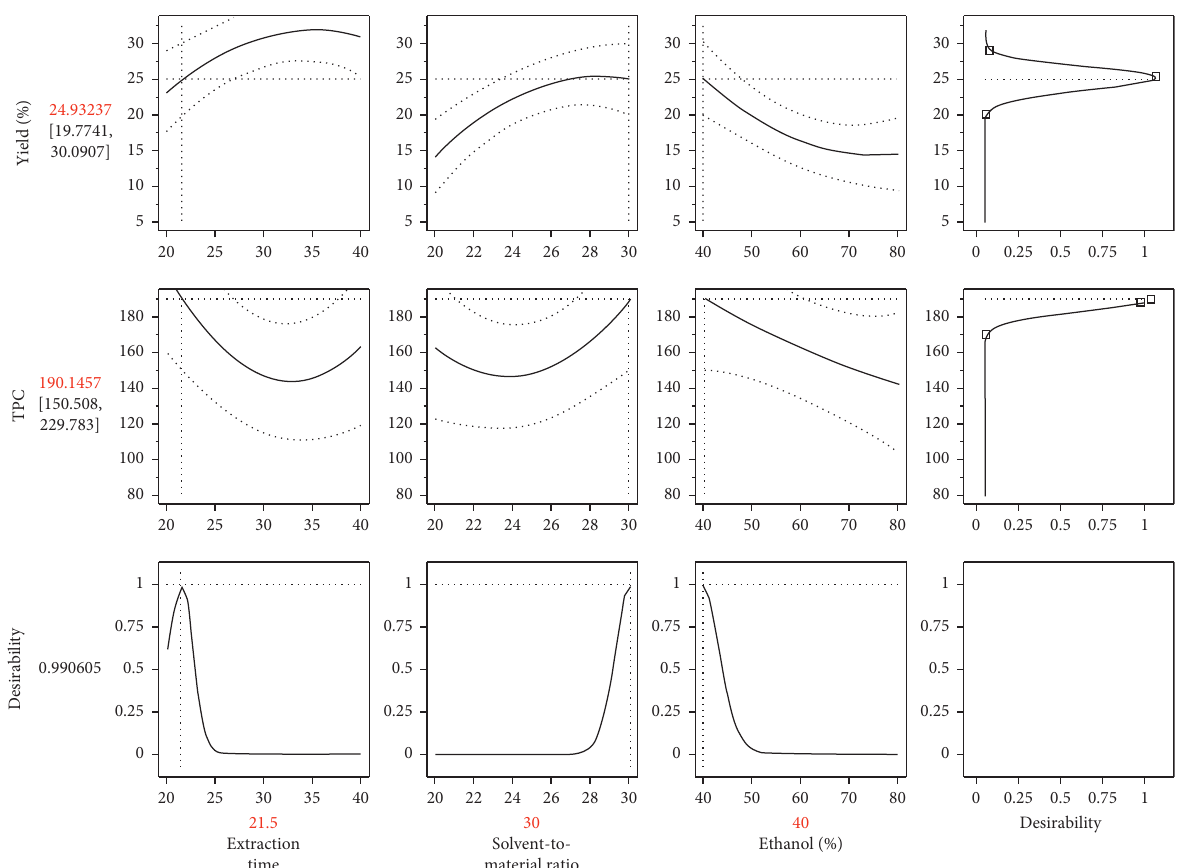
Figure 6: Desirability plot showing the precise operating conditions leading to the optimization of both yield and TPC responses,